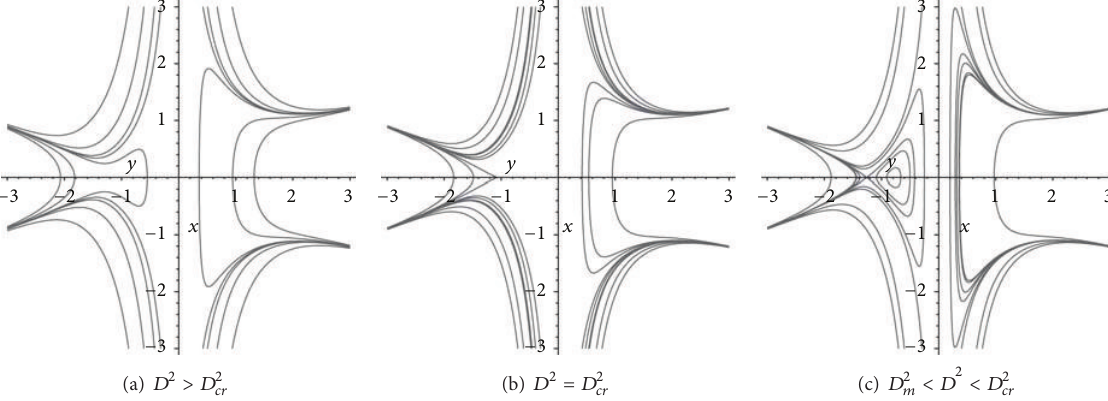
Figure 9: The phase portraits of system (6) for 𝑛 = 2𝑚 + 1 , 𝛽 > 0 , 𝐺 1 < 0 , and 𝜎 < 0